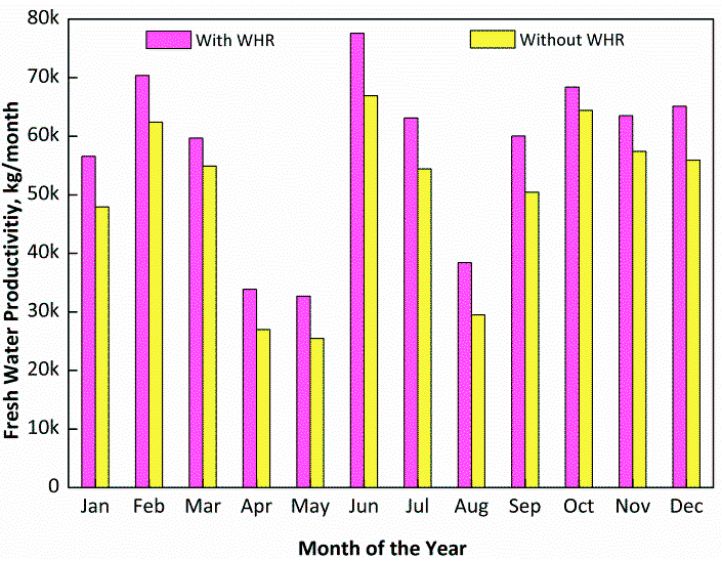
Figure 12. Yearly freshwater production rate with and without waste heat recovery.